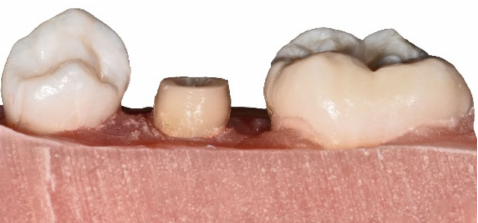
Figure 2. Example of a test model with adjacent teeth and prepared study tooth to receive a P+C restoration.